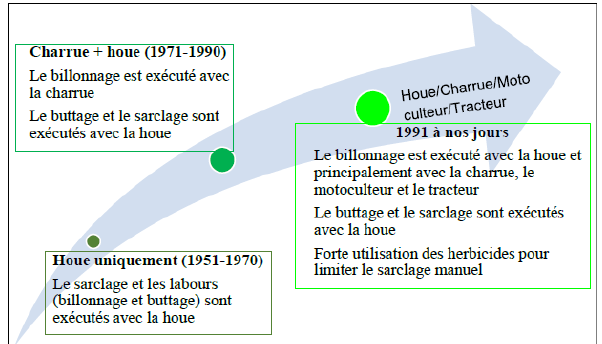
Figure 3. Changements intervenus dans l’outillage de la production agricole.